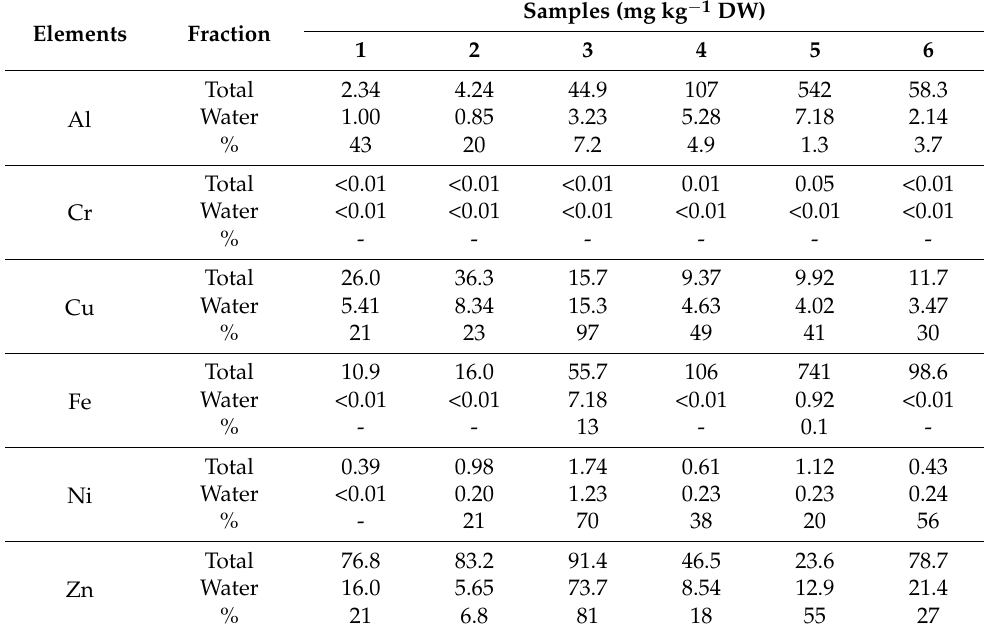
Table 3. Selected trace elements content in six mushroom sample extracts ( n = 3)